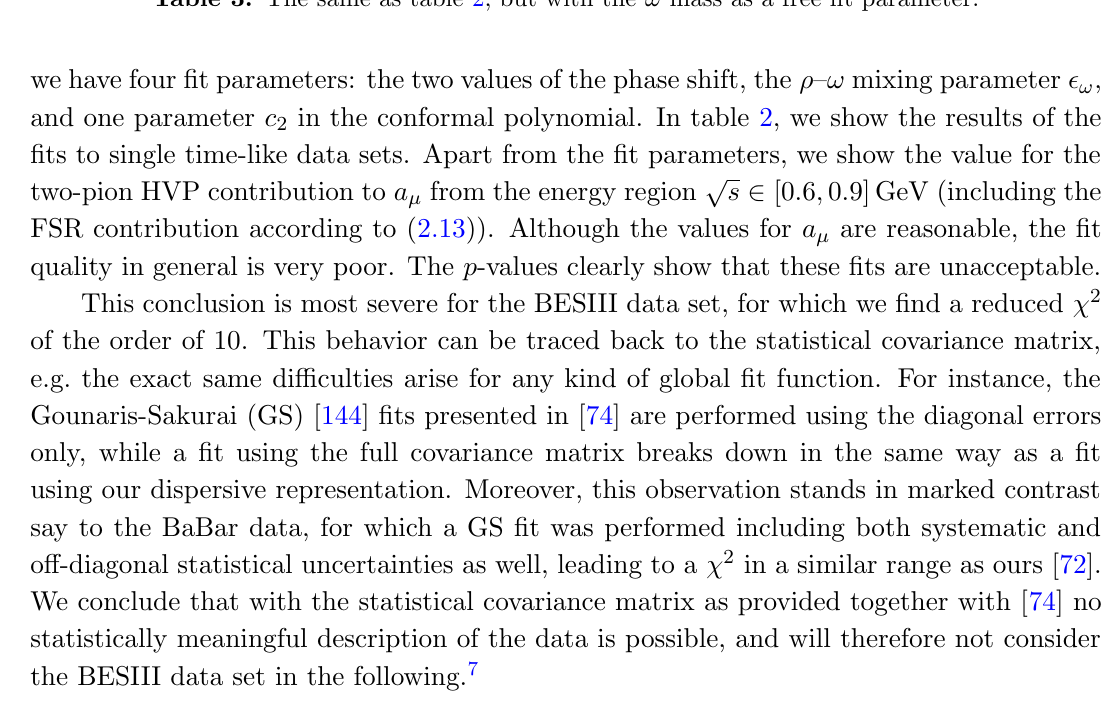
KLOE Table 3. The same as table 2, but with the ! mass as a free (cid:12)t